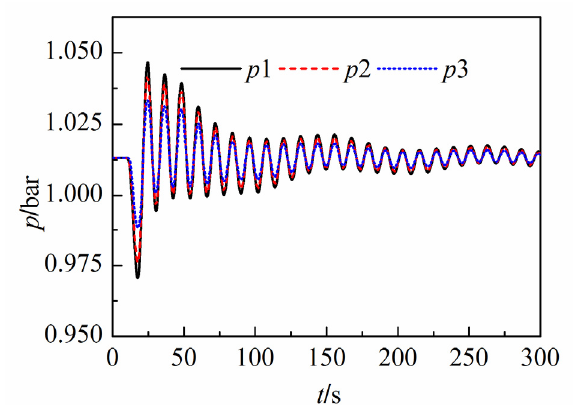
Figure 37. Gas pressure in surge tank #3 for Case 2.